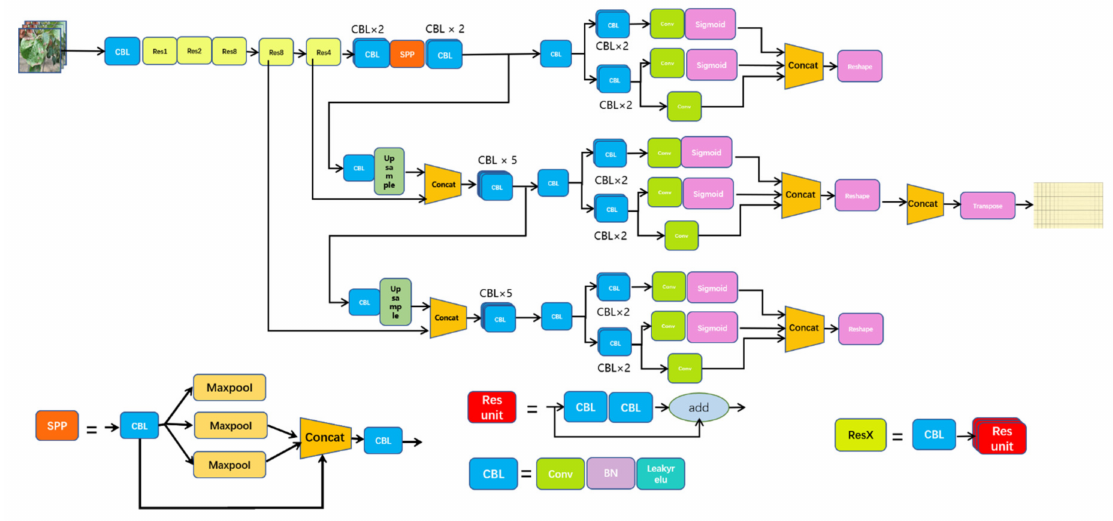
Figure 2. YOLOX network structure